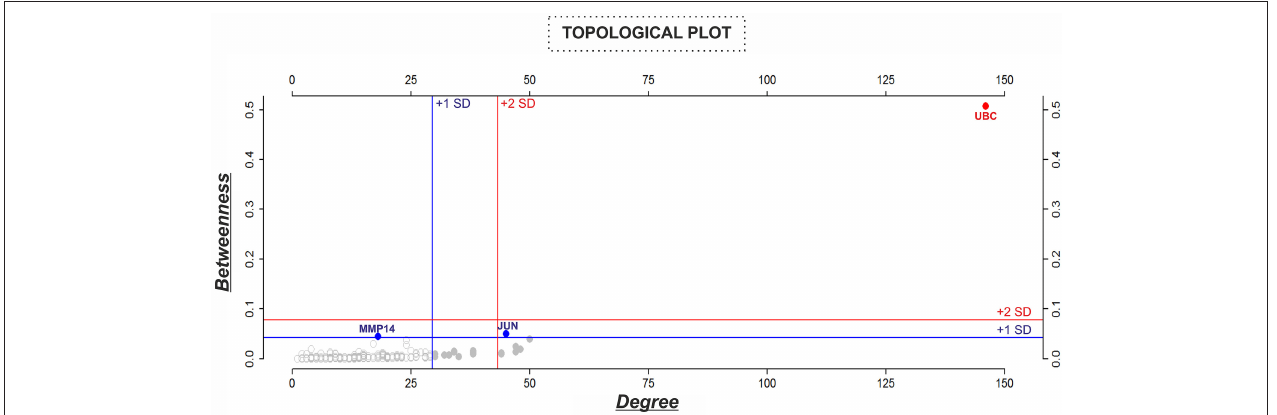
FIGURE 5 | Analysis of the topological properties ( betweenness vs. degree ) of genes/proteins belonging to the “BIOMARK” interactome. Blue and red lines indicate the threshold value for each property or value/s above one ( + 1 SD, blue color) or two ( + 2 SD, red color) standard deviations of the mean. In the graphs, genes/proteins are represented by circles and plotted in blue or red when value/s fall within + 1 or + 2 SD, respectively. Values of centralities above + 1 SD of the mean were selected to identify potential candidate host-derived biomarker/s.